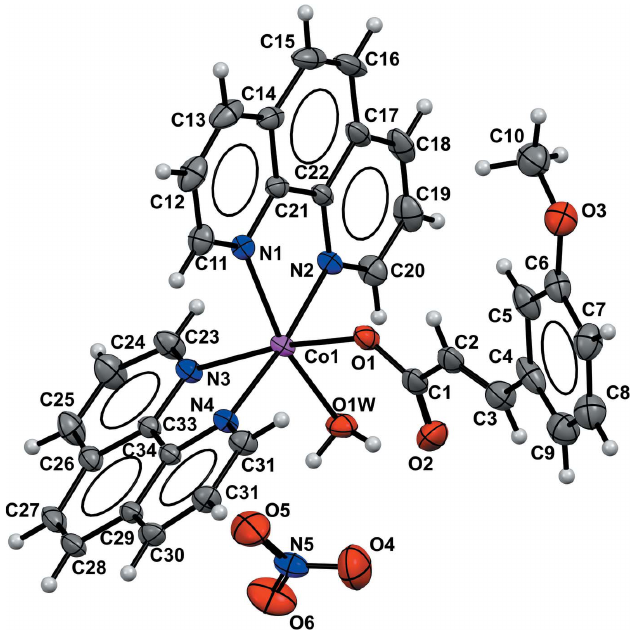
Figure 1 An ellipsoid plot of the title compound showing the atom-labelling scheme with ellipsoids drawn at the 50% probability level and H atoms shown as small spheres of arbitrary radii.